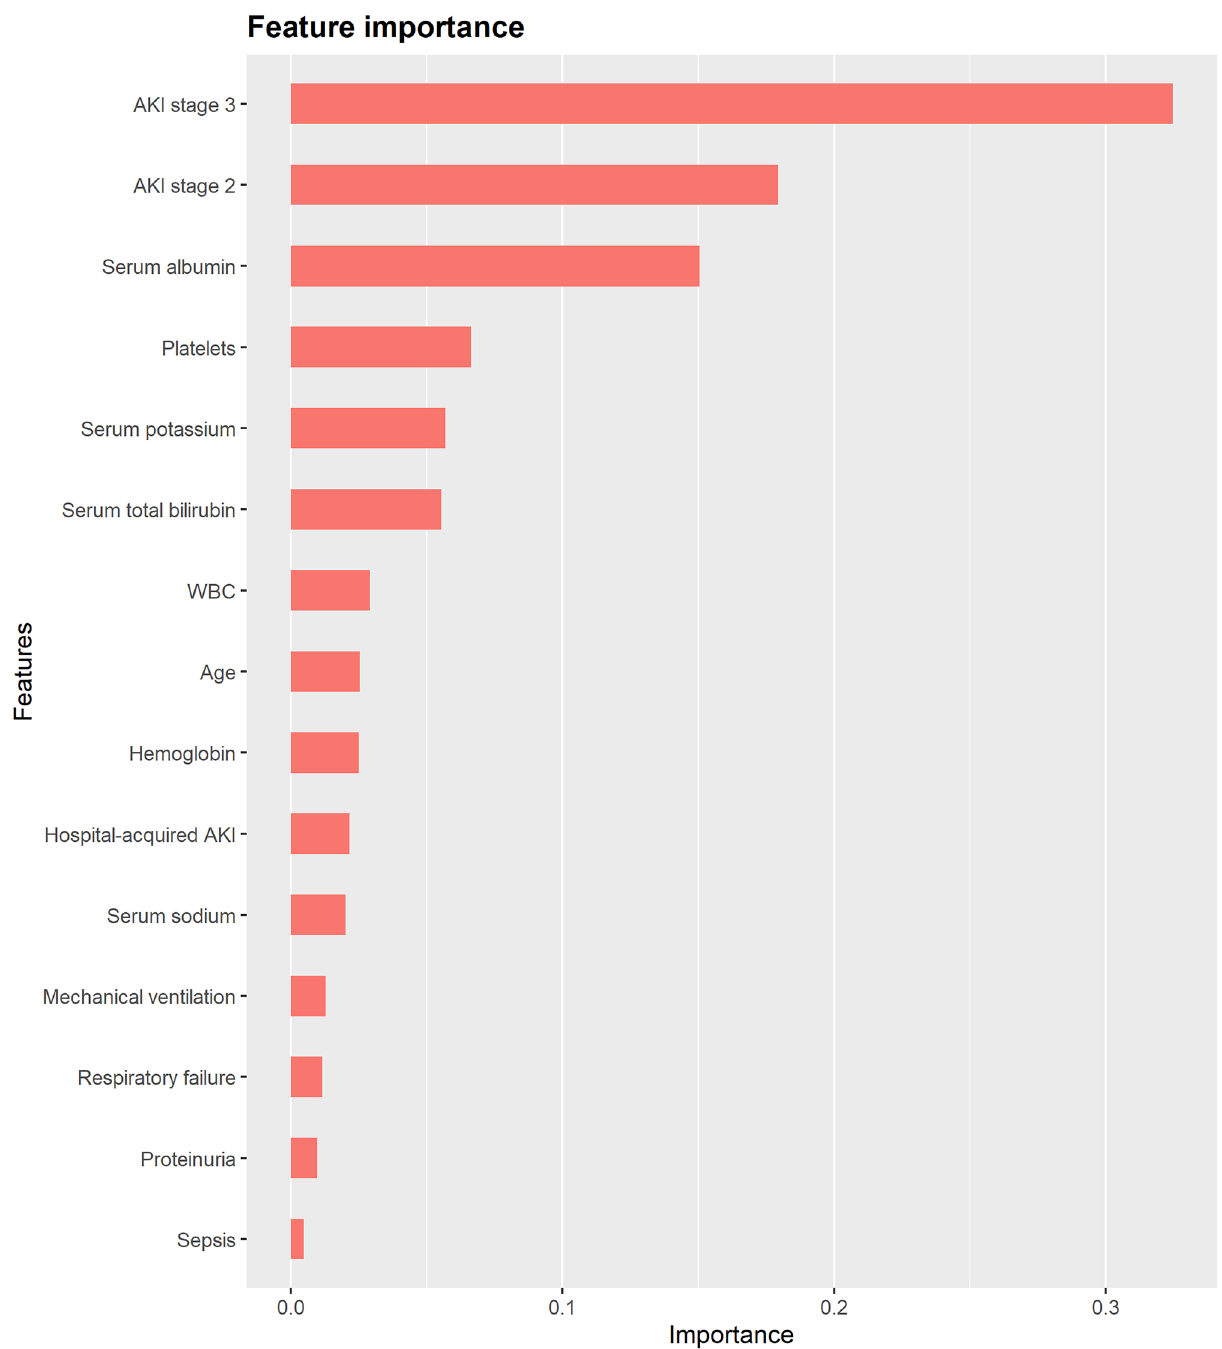
Figure 5. The top 15 important features derived from the XGBoost model for MAKE30. AKI, acute kidney injury; WBC, white blood cell. The figure was created using R 4.1.2 (https:// cran.r- proje ct.